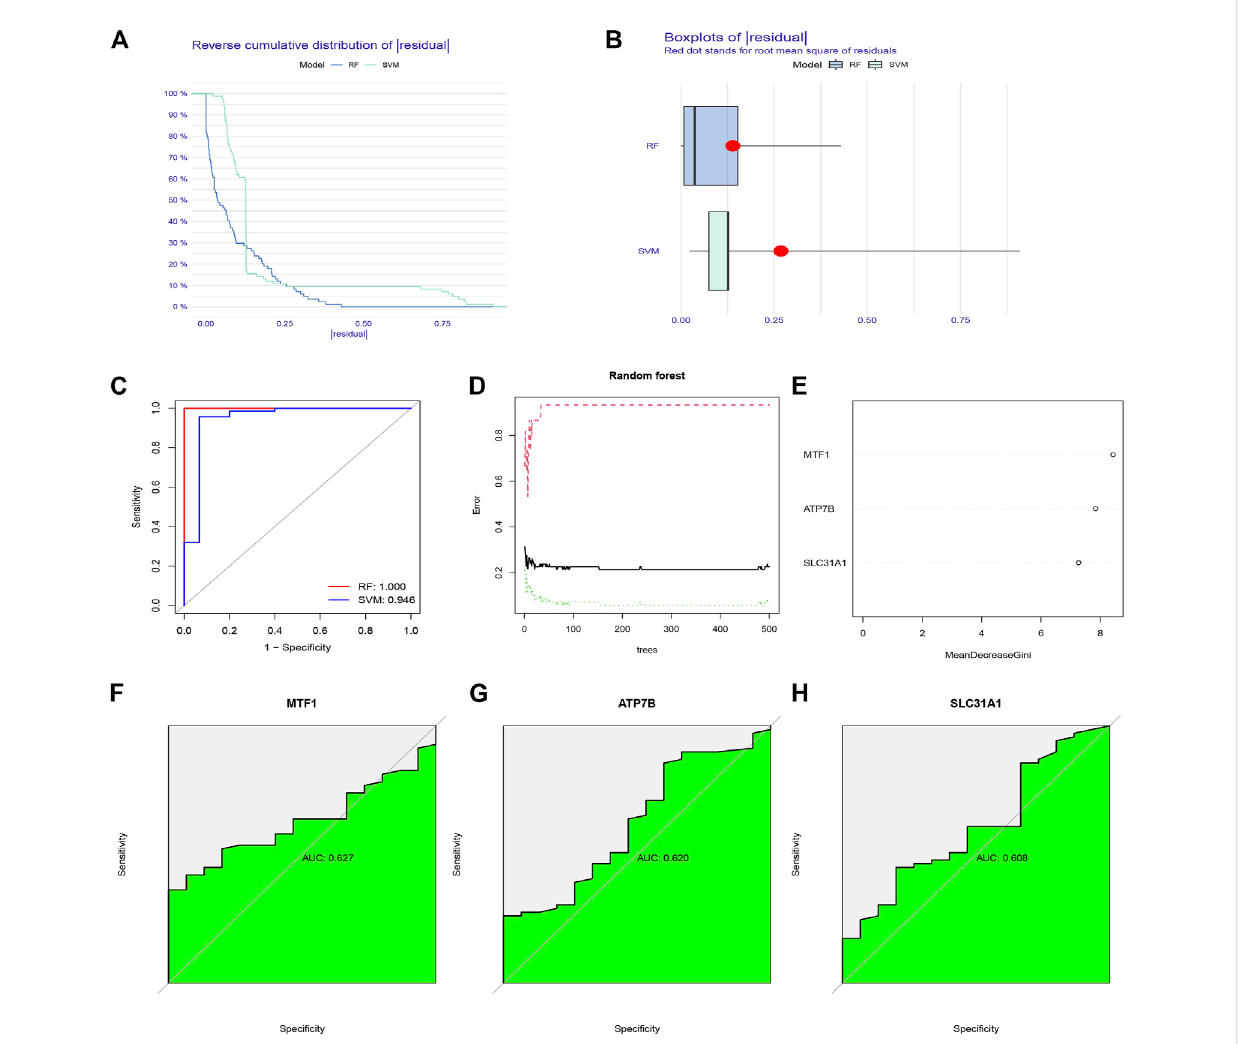
FIGURE 3 The construction of Random forest (RF) model for cuproptosis regulators in psoriasis. (A) Reverse cumulative distribution of residual was plotted to show the residual distribution of RF and support vector machine (SVM) model. (B) Boxplots of residual was plotted to show the residual distribution of RF and SVM model. (C) The AUC value of the ROC curve shows that the RF model has higher accuracy than the SVM model. (D) Ten-fold cross-validation curveindicatedthat theRFmodelhasthehighestaccuracy. (E) The importance ofthe19cuproptosisregulatorsbasedontheRFmodel. (F – H) ROC curve prediction of MTF1, ATP7B, and SLC31A1, indicating that the three model genes can well predict the occurrence of